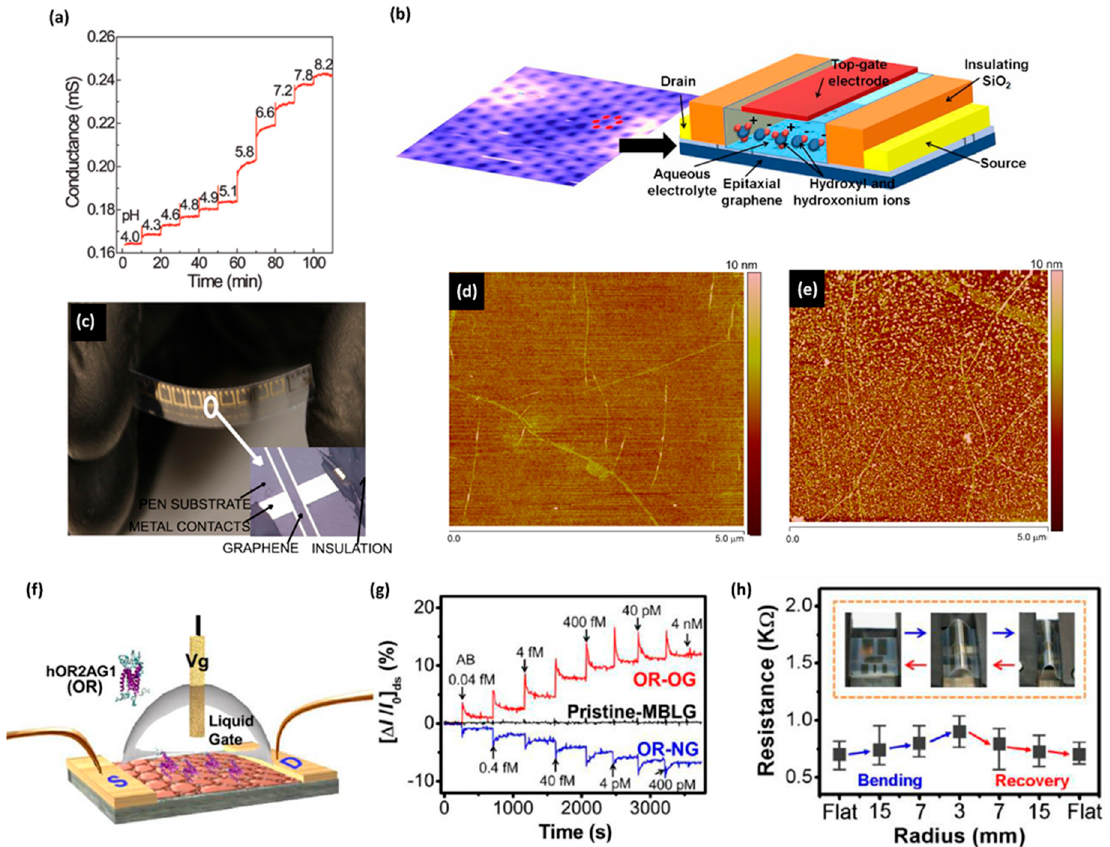
Figure 8. ( a ) Response of electrolyte-gated graphene FET conductance to pH. ( b ) Solution-gated epitaxial graphene FET as a pH sensor. ( c ) Photograph of solution-gated graphene FET on the PEN substrate. ( d ) AFM image of the completely cleaned graphene surface ( e ) AFM image of the graphene surface with resist residues. ( f ) Scheme of the ultrasensitive and flexible graphene FET bioelectronic nose. ( g ) The response of OG, NG and pristine bilayer graphene to the AB solution at various concentrations. ( h ) Electrical stability of the graphene bioelectronic nose. Reprinted with permission from References [99,118,119,121].